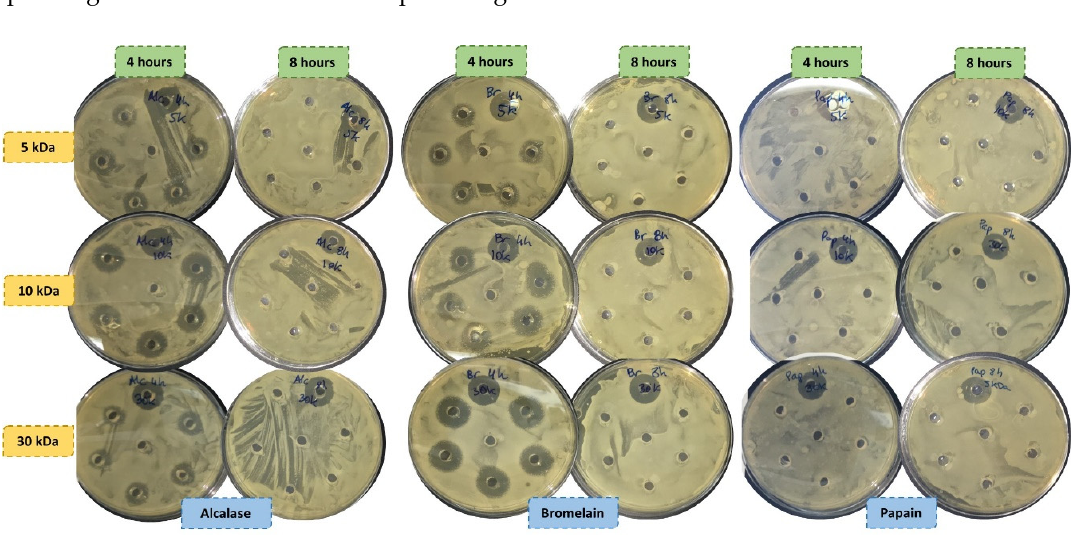
Figure 2. Antimicrobial activity of porcine liver protein hydrolysates obtained with alcalase, bromelain, and papain against Brochothrix thermosphacta .